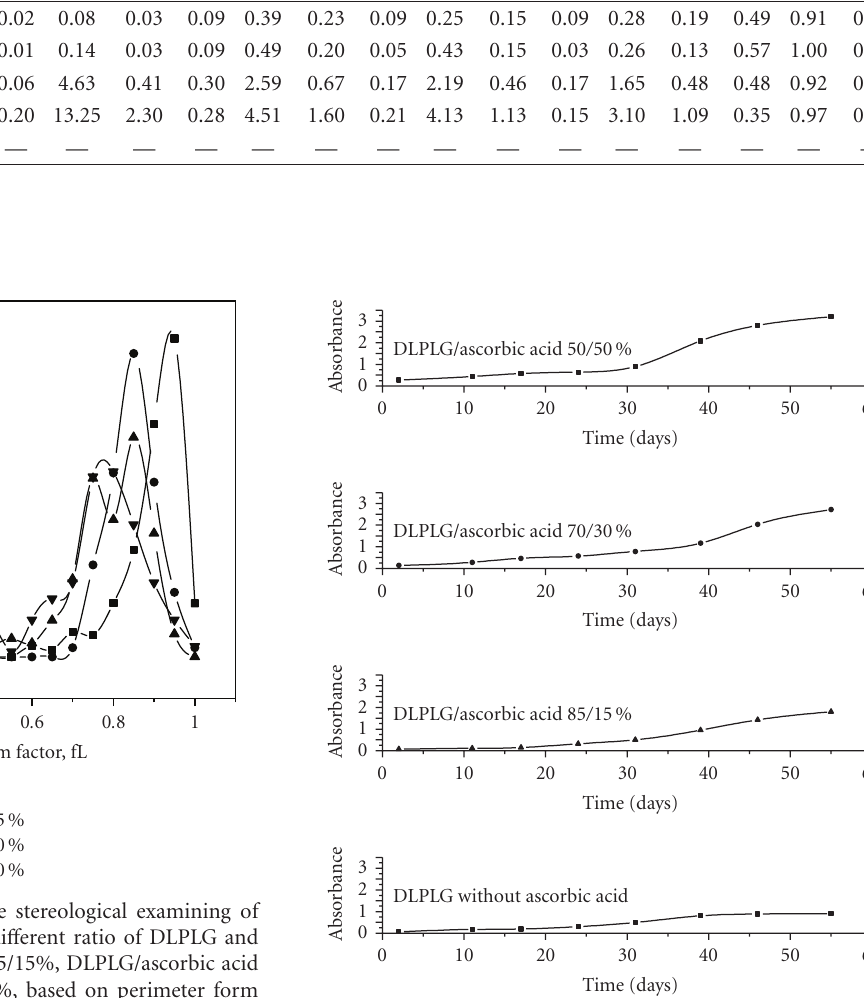
Figure 9: Comparative curves for the dependence of the maximum absorbance from the time of the degradation for the DLPLG with and without ascorbic